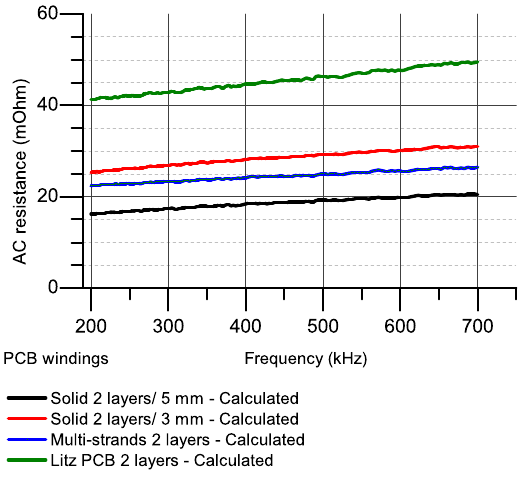
Figure 9. Calculated equivalent skin resistances of one turn two layers windings.